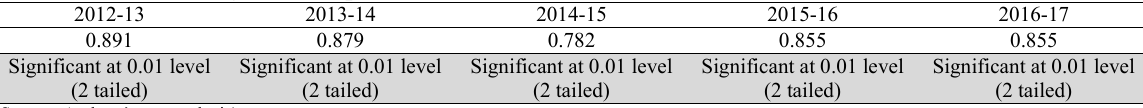
Correlation between year wise performance based ranks & PB ratio based ranks 2012-13